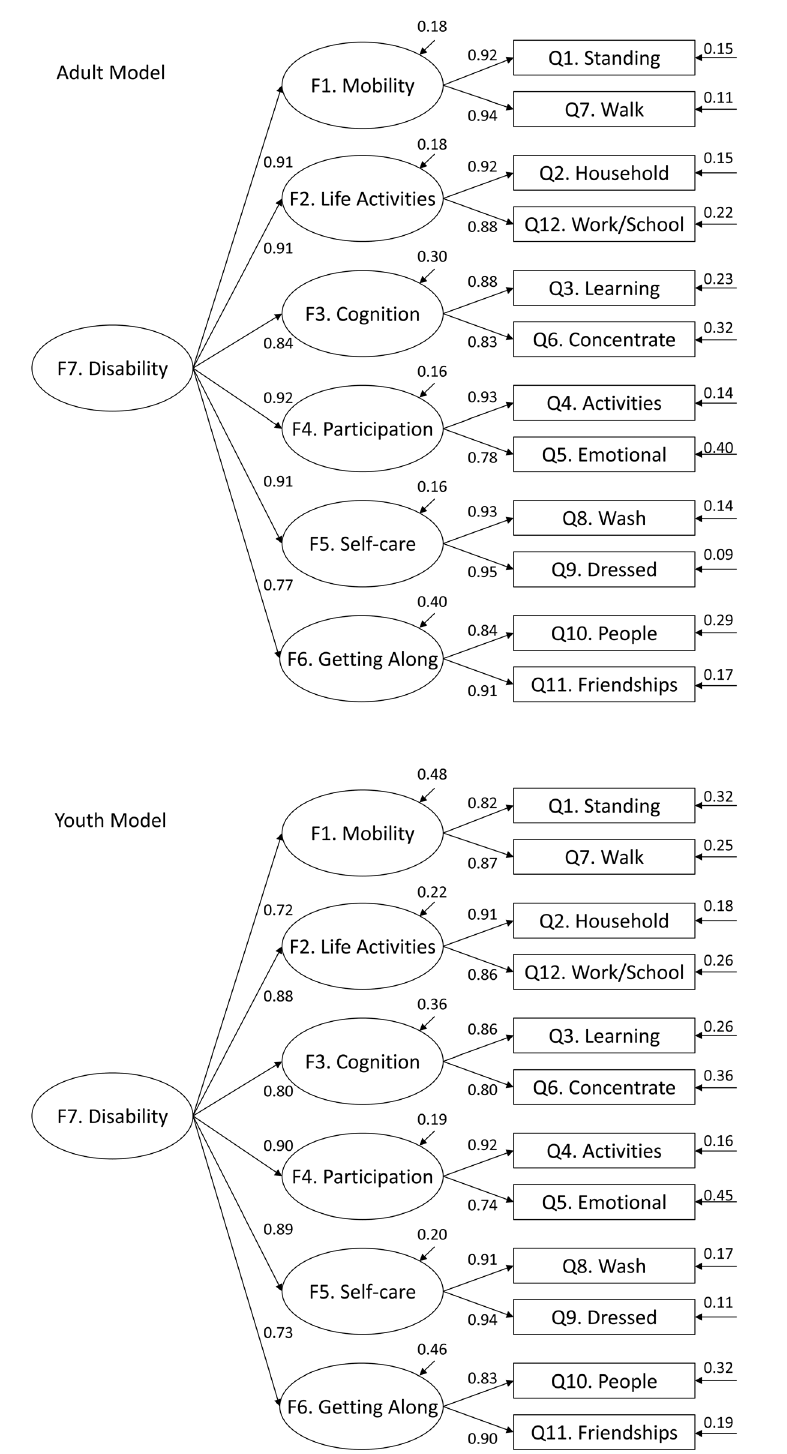
Fig 1. Results of the Invariant Second-Order Factor Model of the WHODAS 2.0. This figure shows the standardized estimates of the higher-order factor structure among adults and youth following the estimation of measurement